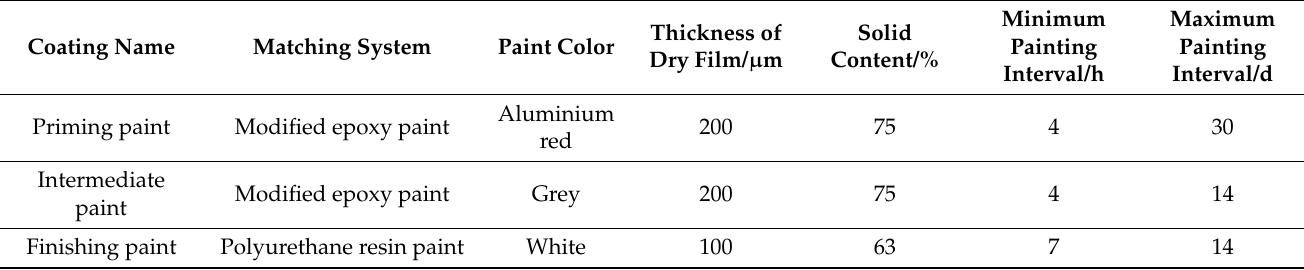
Table 2. Coating matching used for outer plate above the waterline.